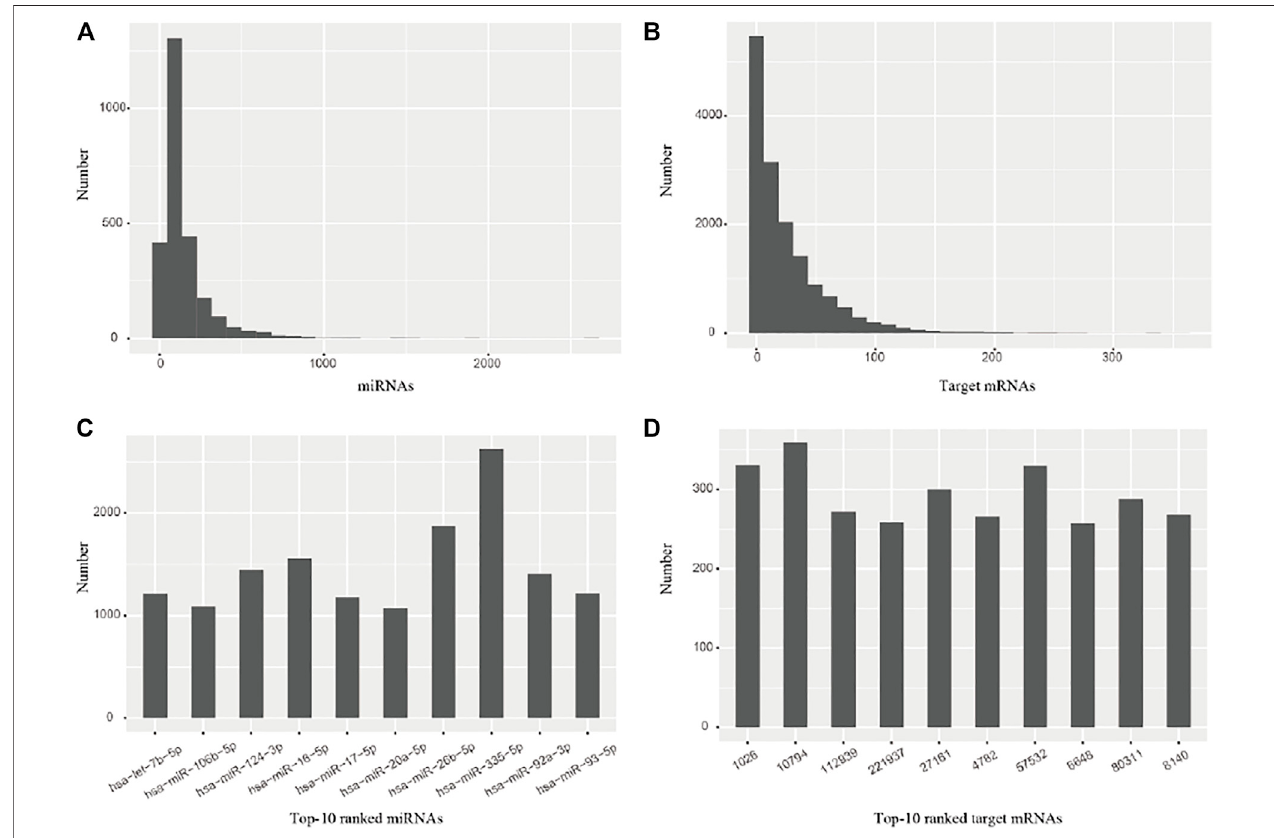
FIGURE 2 | The number distribution of miRNAs and their target mRNAs. (A) miRNAs (B) Target mRNAs (C) Top-10 ranked miRNAs. (D) Top-10 ranked target mRNAs.